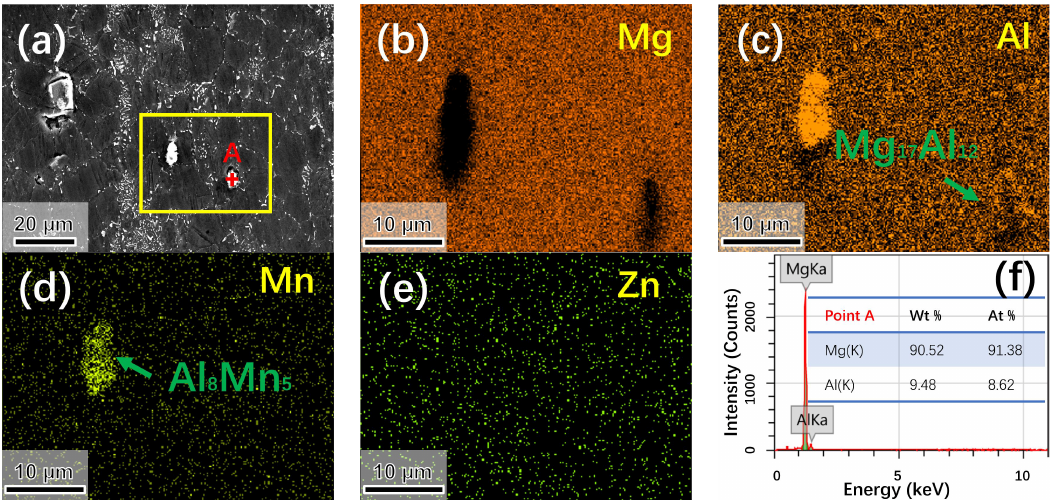
Figure 4. ( a ) Scanning electron microscopy (SEM) microstructure of as-extruded AZ80 alloy; ( b – e ) energy dispersive spectrometer (EDS) mapping images of ( b ) Mg, ( c ) Al, ( d ) Mn, and ( e ) Zn, respectively; ( f ) EDS data of the particle A in ( a ) indicating that the marked phase is Mg 17 Al 12 .